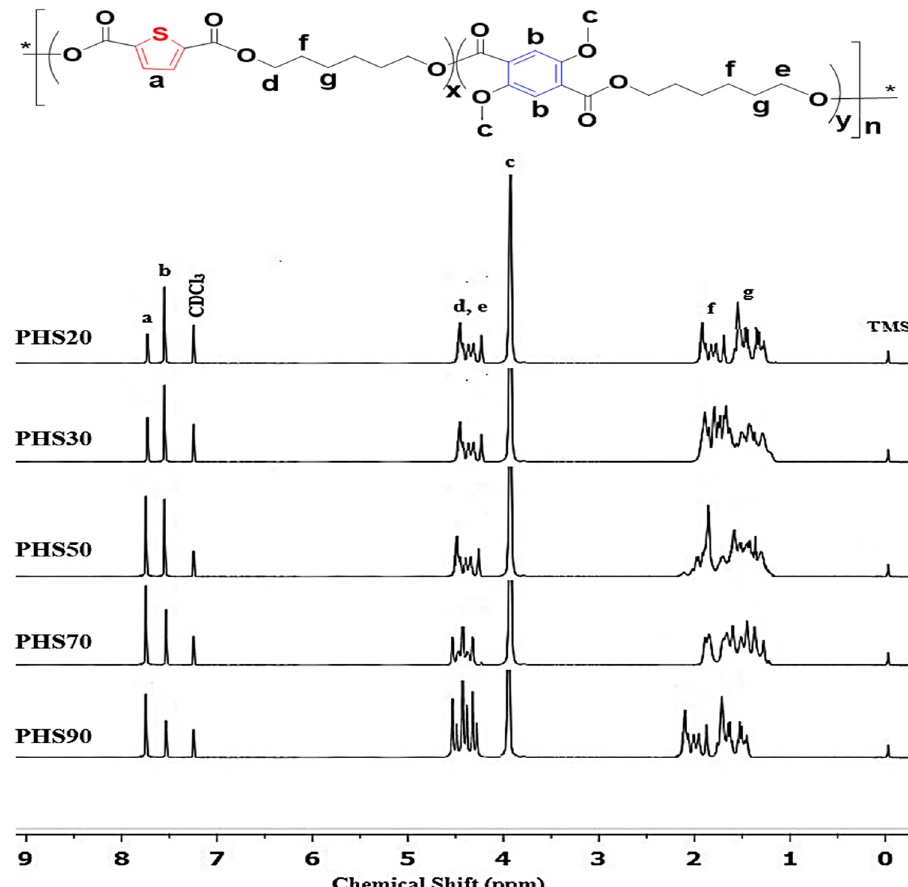
Figure 4. 1 H NMR spectra for copolyesters PHS(20–90). * : polymer chain extension